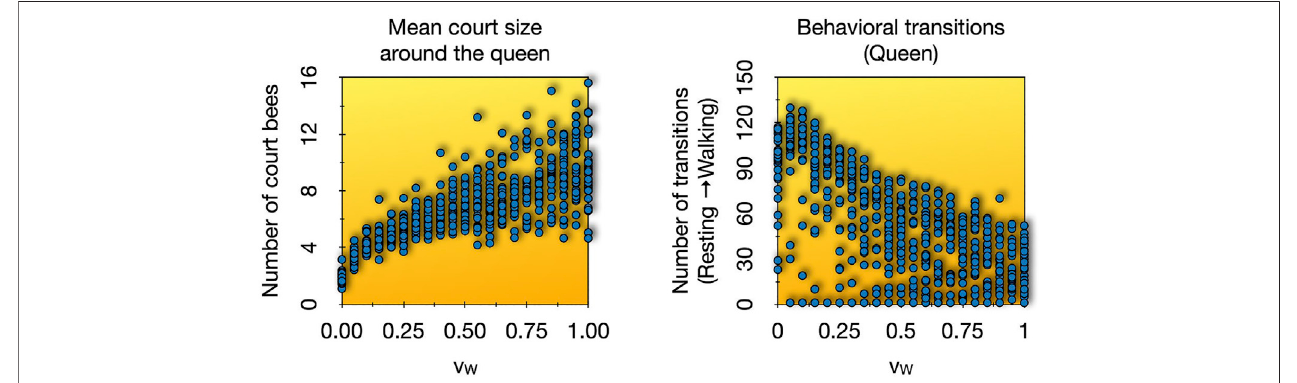
Frontiers in Robotics and AI |